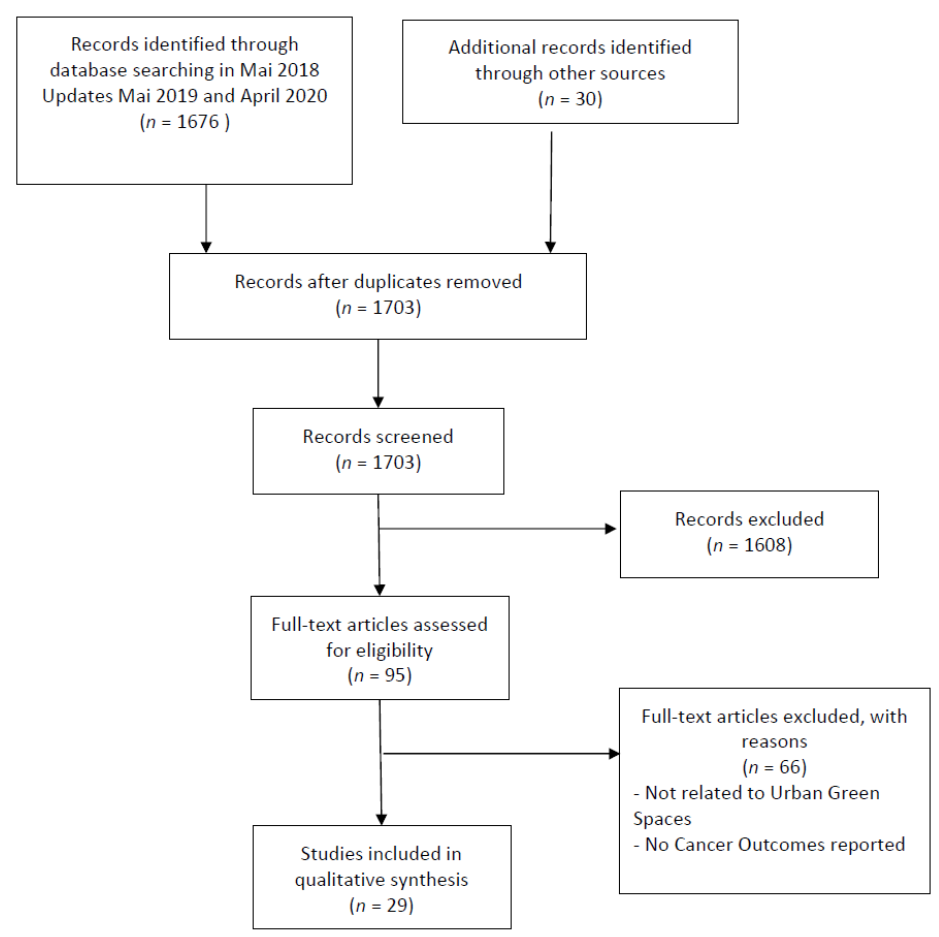
Figure 1. Flow chart of the study selection.